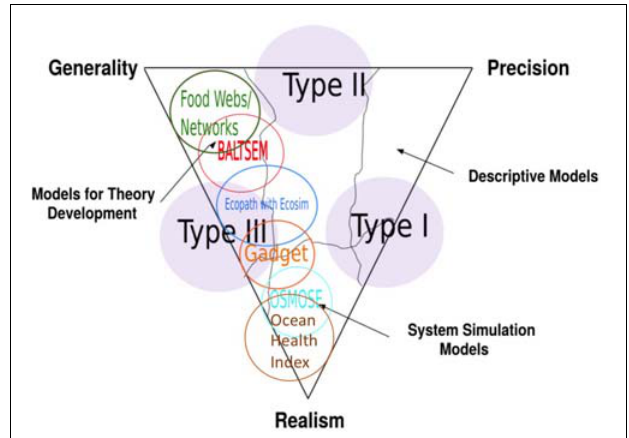
FIGURE 3 | Levins’ modeling trade-offs explore models along the Generality (i.e., Food webs and Networks and BALTSEM as models for theory development) and Realism gradient (i.e., Ecopath with Ecosim, OSMOSE, Gadget, Ocean Health Index as System Simulation Models). These are all Type III modeling frameworks, which sacrifice precision for the sake of generality and realism. Along the generality-realism axis, Type I models sacrifice generality for the sake of realism and precision and Type II models sacrifice realism for the sake of precision and generality.